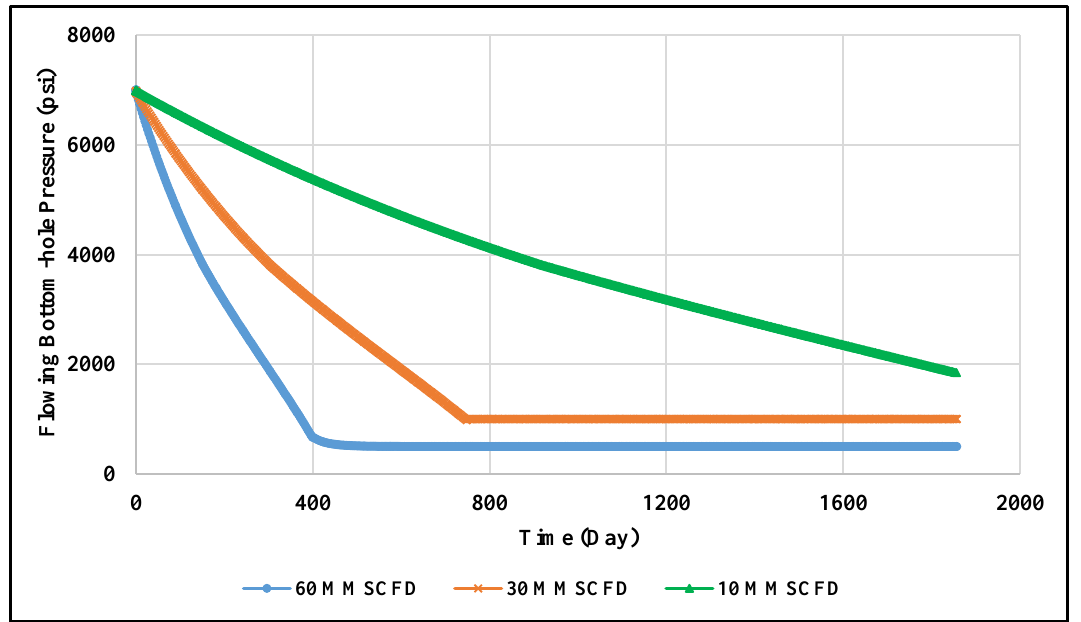
Figure 16. Profiles of flowing bottom-hole pressure at gas-production rates of 10, 30, and 60 MMSCFD, respectively.